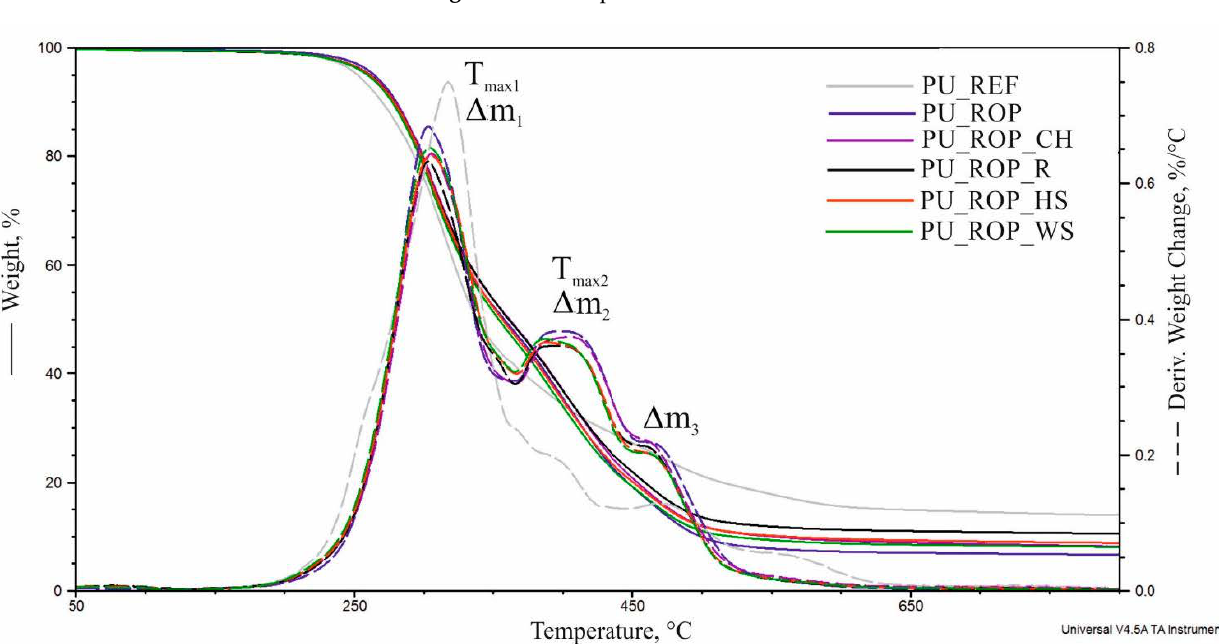
Figure 10. FTIR spectra of the foams.